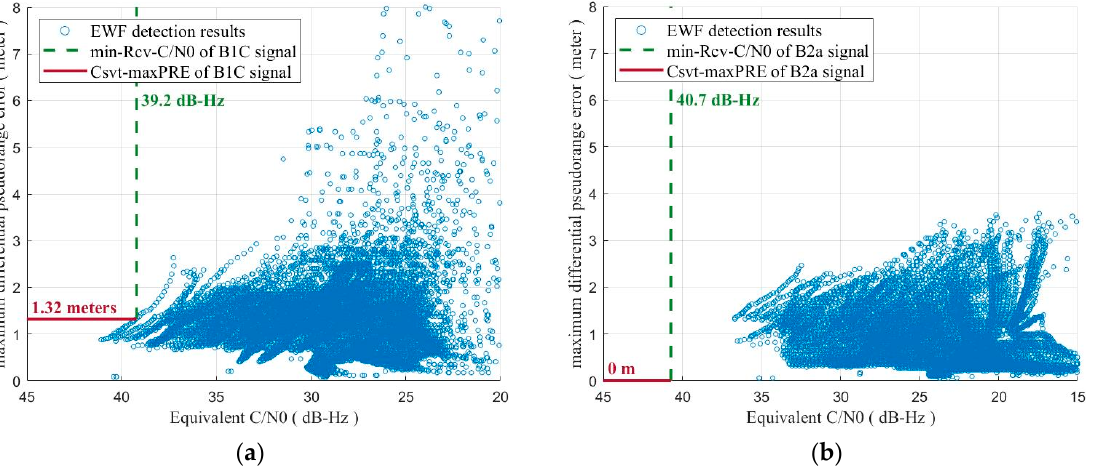
Figure 8. Evaluation results of the CDO-based SQM algorithm with a sampling frequency of 24 MHz and bins of 0.020 B1-chips. ( a ) B1C signal; ( b ) B2a signal.